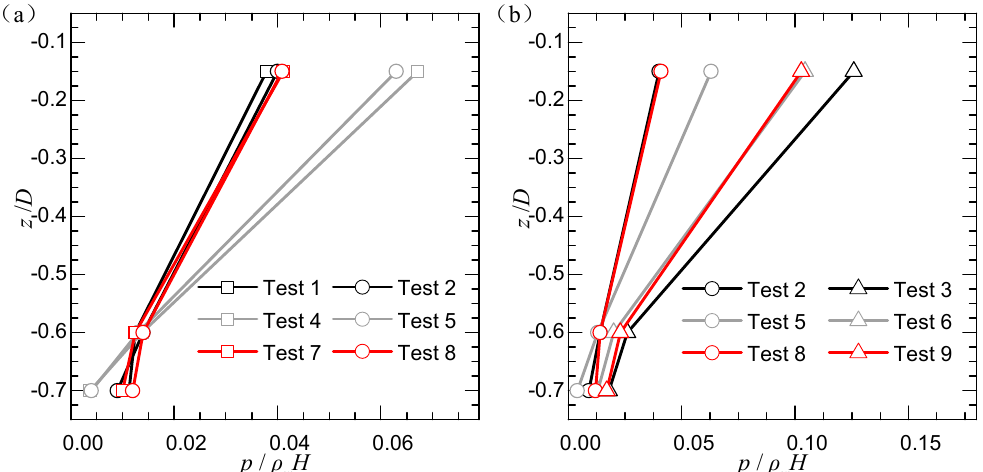
Figure 9. Effect of ( a ) wave height and ( b ) wave period on the vertical distributions of the excess pore pressure amplitude along with the soil depth.